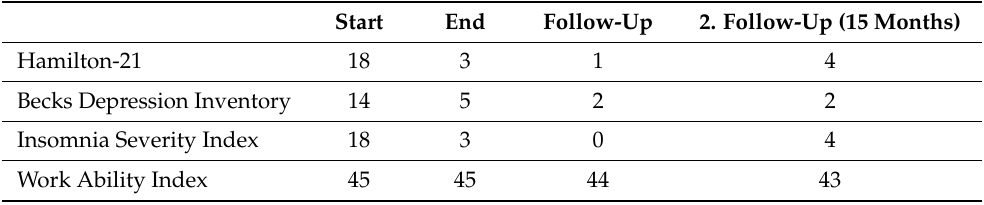
Table 2. Overview over time of